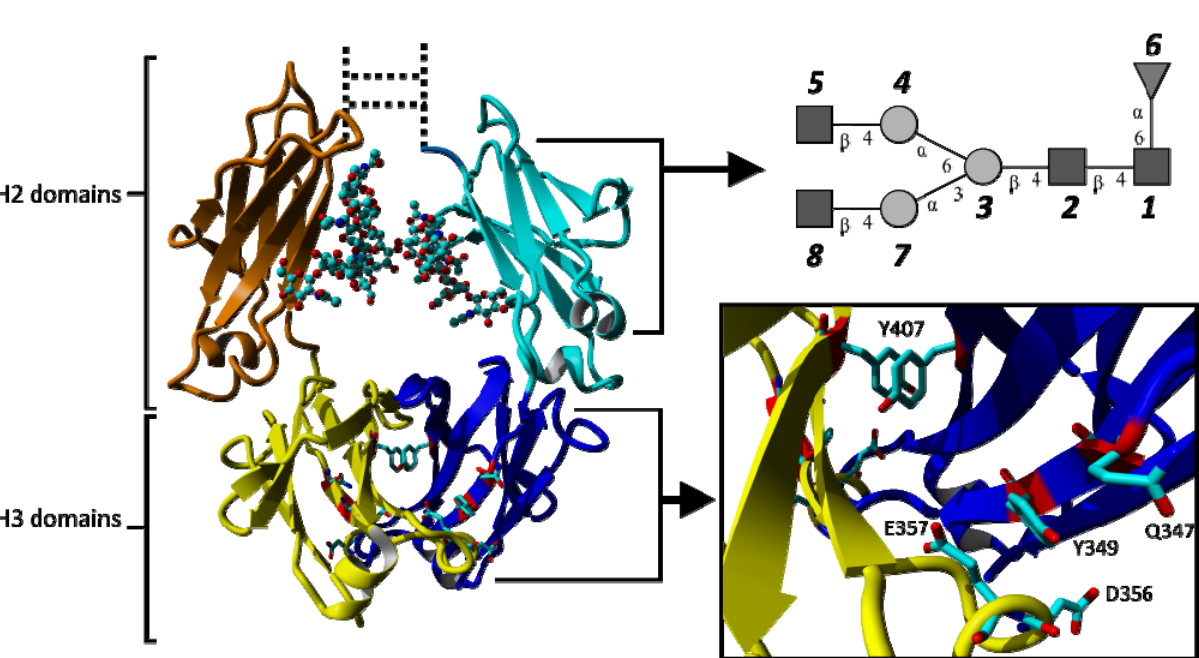
Figure 1. Graphical representation of the crystallizable fragment (Fc) of human IgG1 consisting of two N -glycosylated CH2 domains and two CH3 domains (individual domains are shown in different colours). Coordinates were taken from the crystal structure 1OQO. The glycosylation is shown in ball and stick representation and schematically in the top-right panel. Y407 located at the interface of the two CH3 domains forms a favorable stacking interaction. The position of the point mutation Q347 and adjacent residues affected by the exchange of glutamine by glutamate (Q347E) are shown in stick representation. Glycan numbering reflects the order in which they are attached to the topologies used for simulations (GlcNac: 1 , 2 , 5 , 8 ; Mannose: 3 , 4 , 7 ; Fucose: 6 ). The hinge region and disulphide bonds connecting the two CH2 domains are shown as dotted